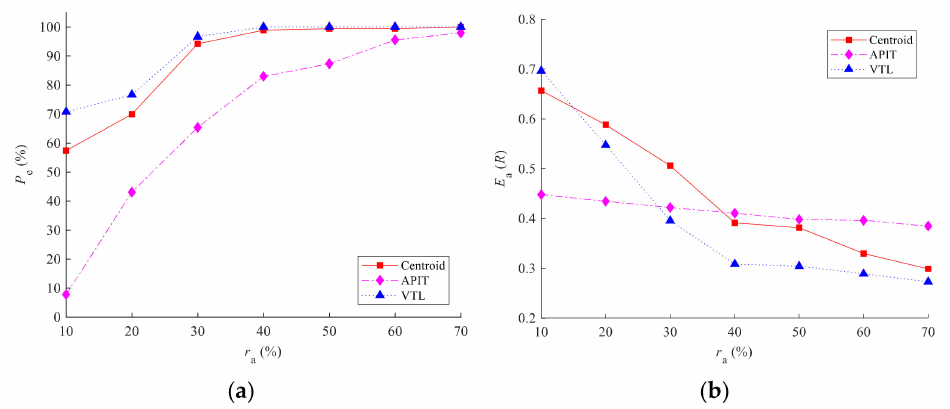
Figure 11. Effect of ratio of anchor nodes r a on the three schemes ( S = 100 × 100 m 2 , N t = 100, R a = R = 20 m, E GPS = 0, K = 6). ( a ) Estimation percentage P e . ( b ) Average estimation error E a .